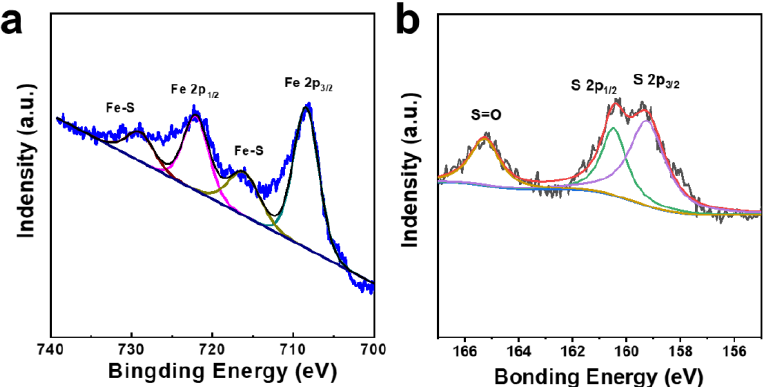
FeS 2 / C Figure 5. High-resolution X-ray photoelectron spectroscopy (XPS) of ( a ) Fe and ( b ) S in as-prepared FeS 2 /C nanowires.